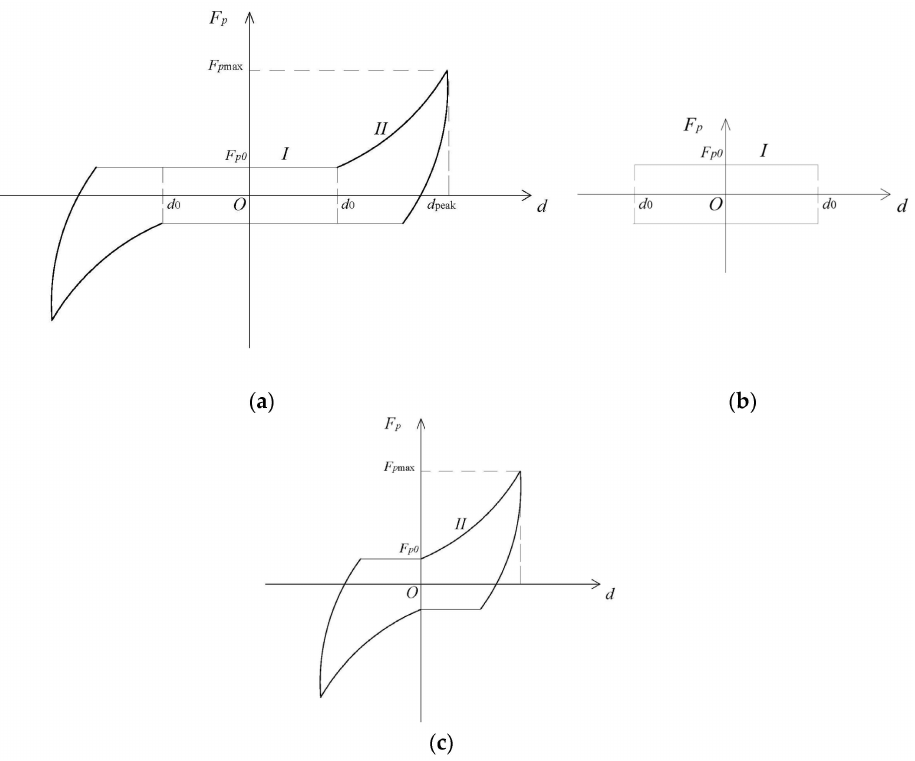
Figure 13. Modelling of a typical hysteretic loop for dry stack infill panel: ( a ) Full hysteretic loop for DSP; ( b ) Constant friction stage; ( c ) Equivalent strut